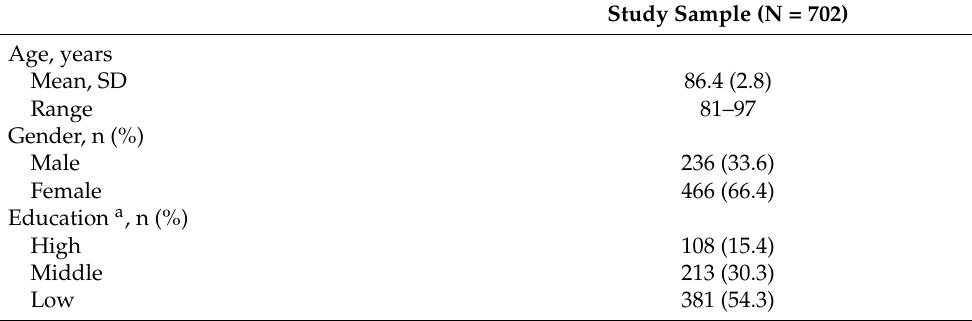
Table 1. Sociodemographic Characteristics of the study sample at